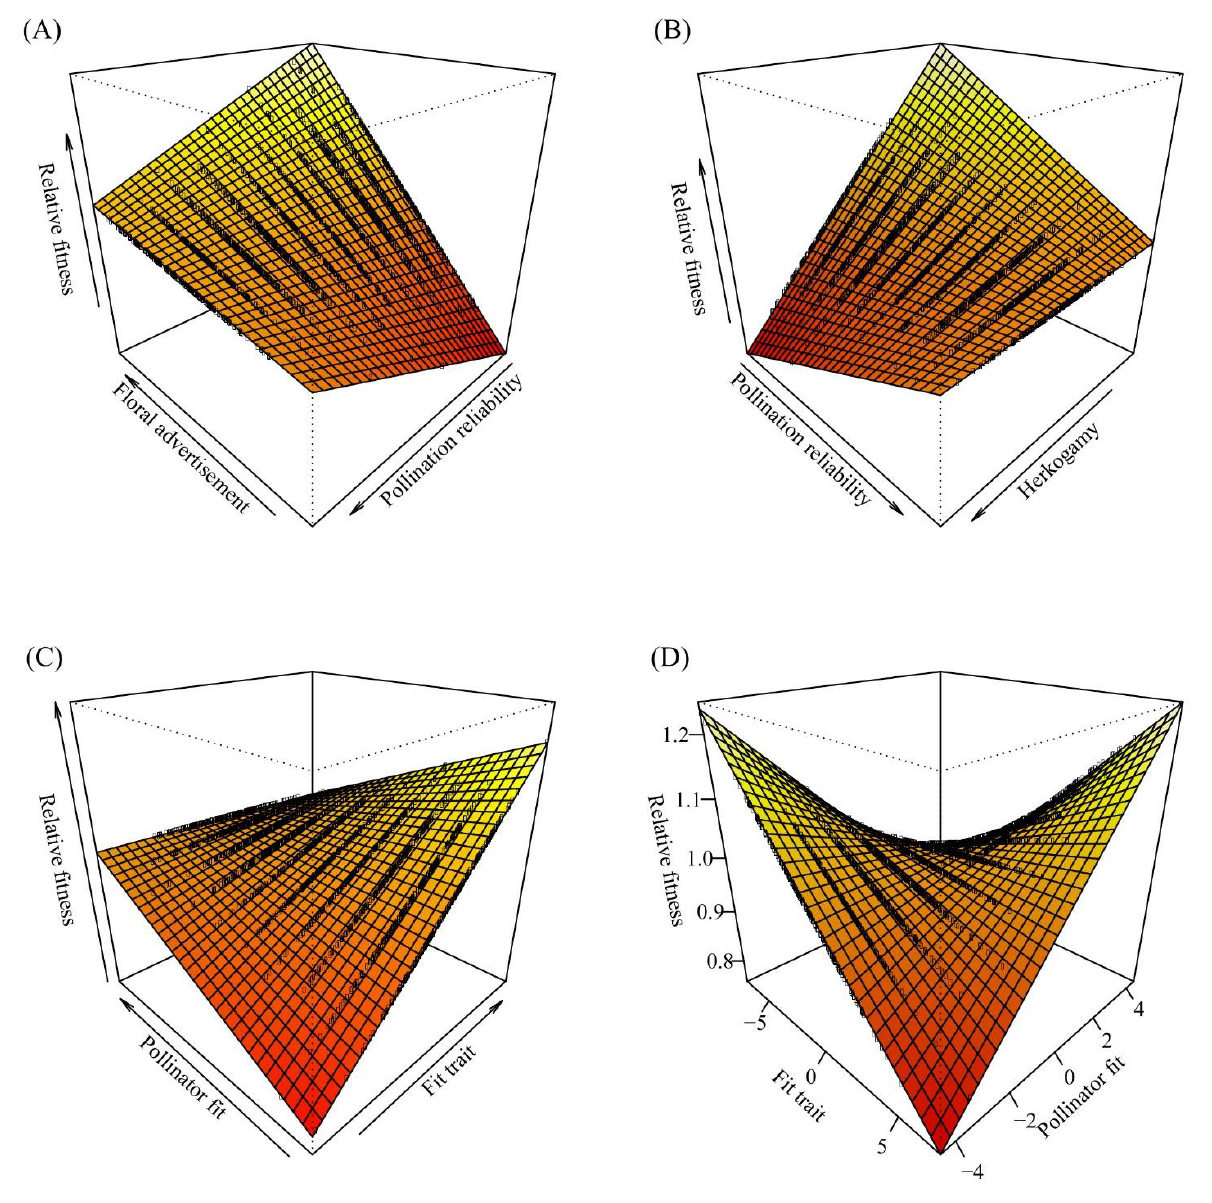
Figure 4. Examples of how the linear component of fitness surfaces for floral traits involved in pollinator attraction, self- pollination and flower-pollinator fit may be expected to covary with ecological variables (pollination reliability and correspondence between pollinator and floral trai ts (‘pollinator fit’). In all panels, the rows of black symbols indicate the trait distribution of 10 hypothetical populations. With decreasing population-level pollination reliability we expect greater opportunity for selection and stronger positive directional selection on floral advertisement (A) and/or stronger negative selection on herkogamy and other traits mediating self-pollination (B). Selection on pollinator-fit traits (e.g. reward-stigma distances, spur length) is expected to covary with population-mean flower pollinator fit (e.g. pollinator size – fit trait), but details will vary across systems. In (C), selection on the fit trait occurs at poor flower-pollinator fit but tends to zero as fit improves. In (D), selection on the fit trait is positive when the pollinator trait is larger than the fit trait (positive values), negative when the pollinator trait is smaller than the fit trait (negative values), and no directional selection occurs when the fit is